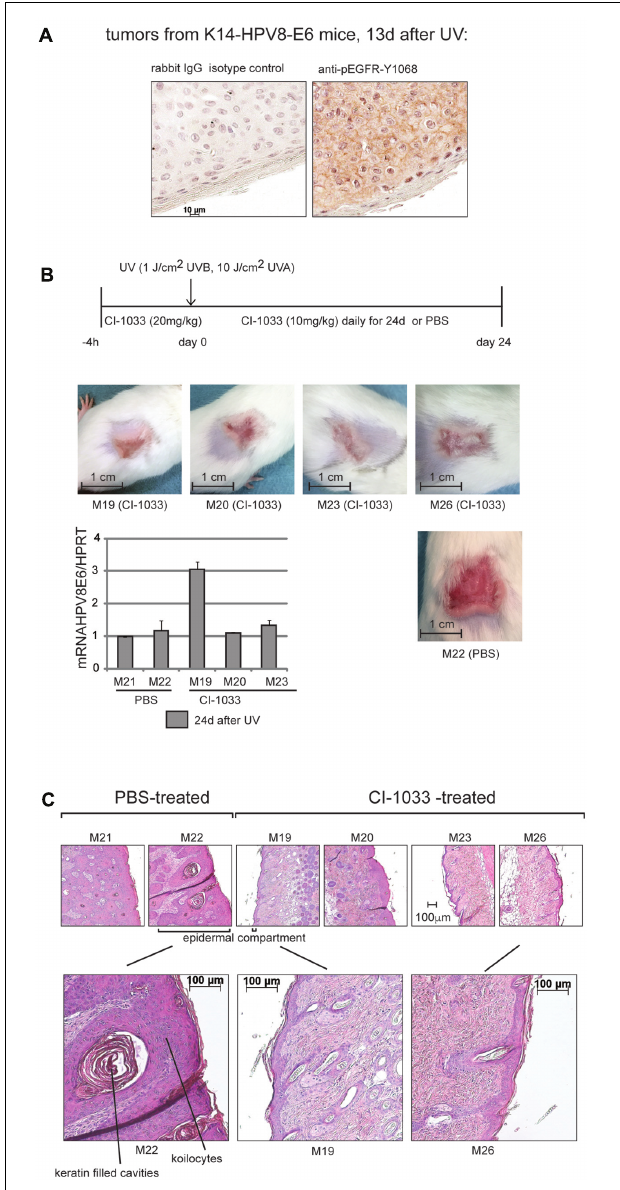
FIGURE 4 | Inhibition of the RTK-activity of the EGFR by the pan-ErbB-inhibitor Canertinib (CI-1033) suppresses UV-induced papillomatosis in K14-HPV8E6 transgenic mice. (A) Immunohistochemical staining of paraffin embedded sections obtained from skin of K14-HPV8E6 transgenic mice 13 days after UV-exposure with the anti-pEGFR-Y1068 or rabbit IgG isotype control (magnification 1:400). (B) Transgenic mice obtained either Canertinib (CI-1033) (20 mg/kg weight) or the same volume of PBS 4 h prior UV-irradiation followed by applications of Canertinib once daily at a dose of 10 mg/kg weight or 150 µ l PBS for 24 days, as given in the time line. The pictures represent examples of the lesions from four mice treated with CI-1033 (M19, 20, 23, and M26) and from one control mouse which obtained PBS (M22). The graph beneath shows the quantification of RT-PCR results with RNA isolated from two PBS and three Canertinib-treated animals to demonstrate the expression of HPV8E6. (C) Histology with H/E staining of skin section obtained from two PBS-control (M21 and M22) and four Canertinib (CI-1033)-treated animals (M19, M20, M23, and M26) 24 days after